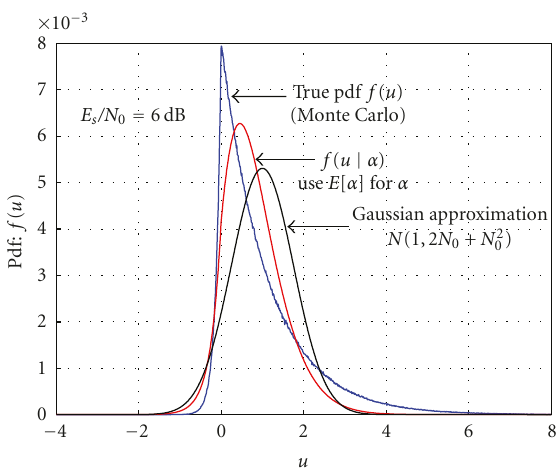
} in a conventional k − 1